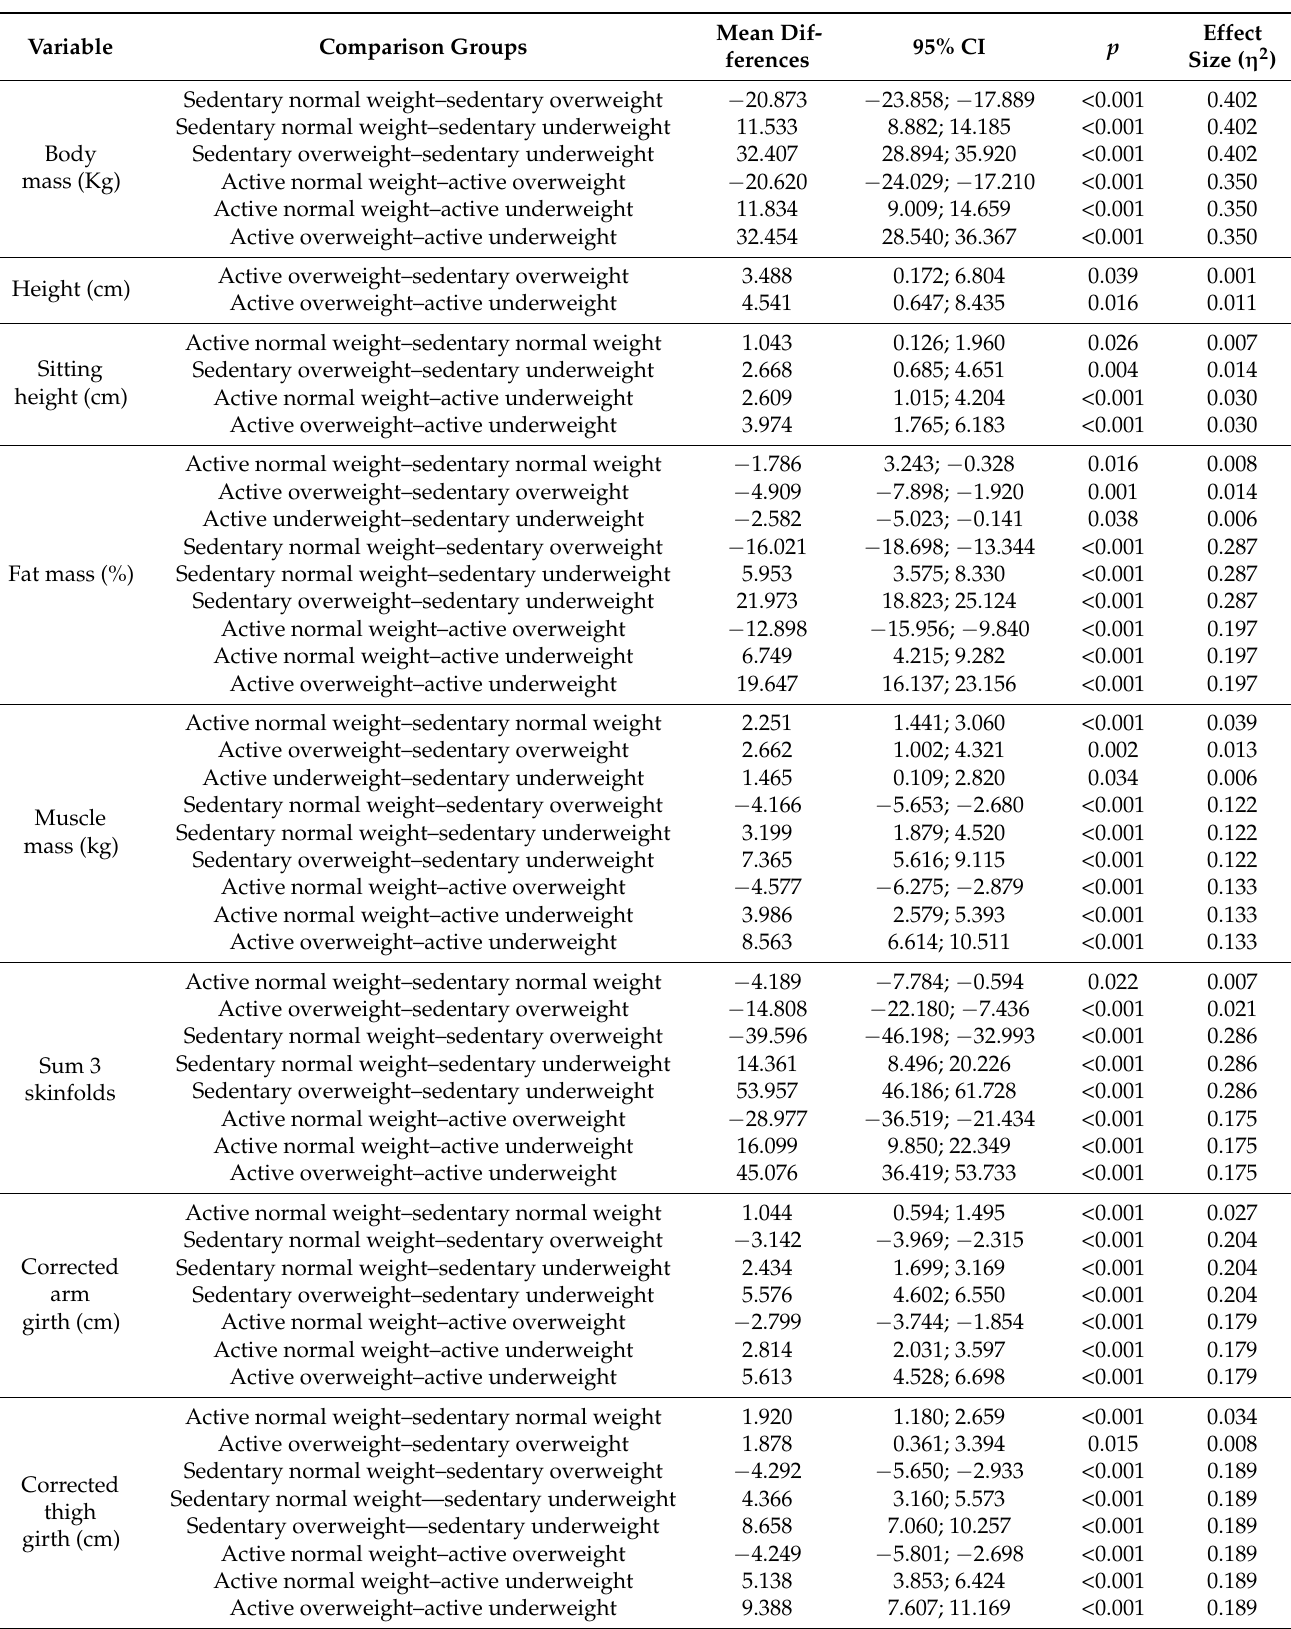
Table 3. Bonferroni post hoc analysis of anthropometric, nutritional, and physical fitness variables of active and sedentary adolescents according to their